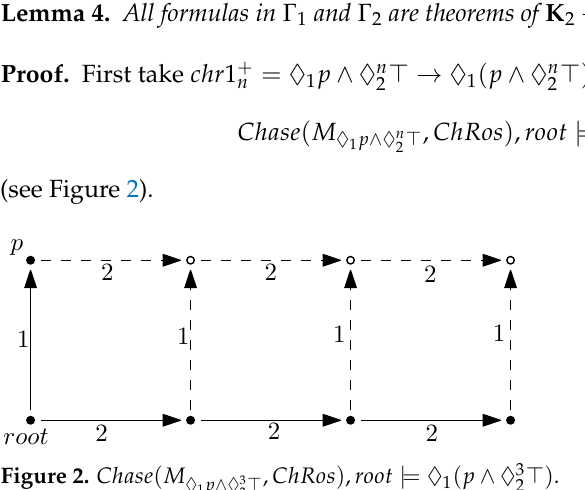
Figure 2. Chase ( M ♦ The argument for chr 2 +